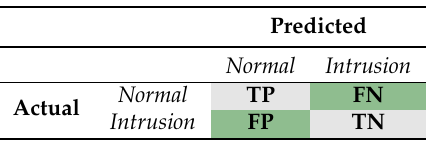
Table 3. Confusion matrix.